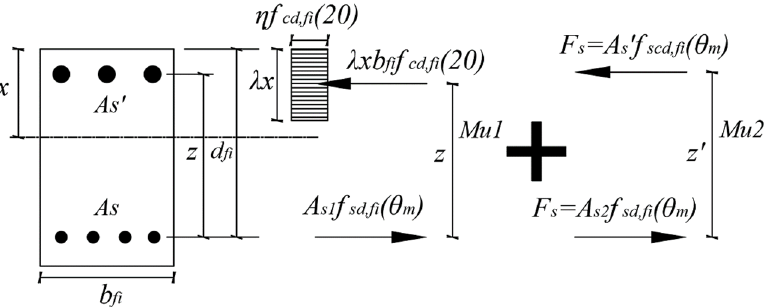
Figure 20. Stress distribution at ultimate limit state for a rectangular concrete cross-section with compression reinforcement (EN 1992-1-2 Annex B, reproduced).